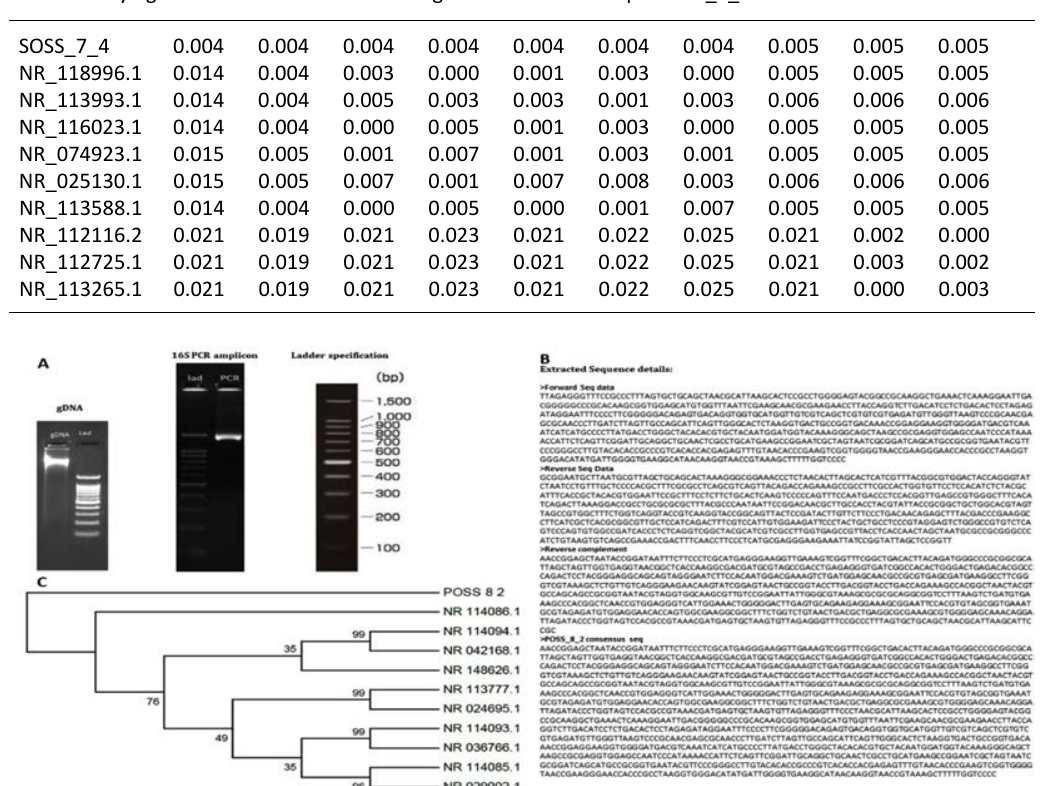
Fig.6. Molecular identification of the samples isolated. (A) PCR amplification of isolated sample POSS_8_2. (B) DNA sequencing results from the amplified samples. (C) Development of a phylogenetic tree for sample